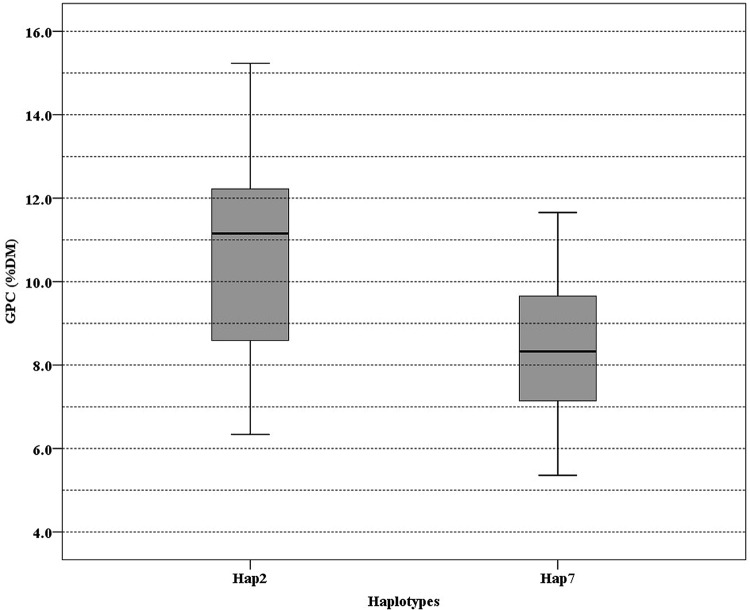
Boxplot of grain protein content (GPC) variation among 176 barley accessions grouped according to the haplotype of Hap2 and Hap7. Lines across the boxes depict the medians. Boxes indicate the interquartile range. Whiskers represent 95% confidence intervals.